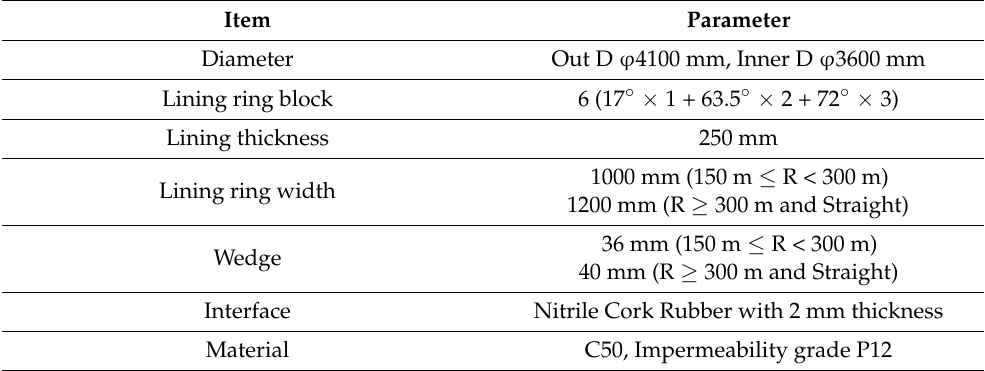
Table 1. Main design parameters of shield segment.